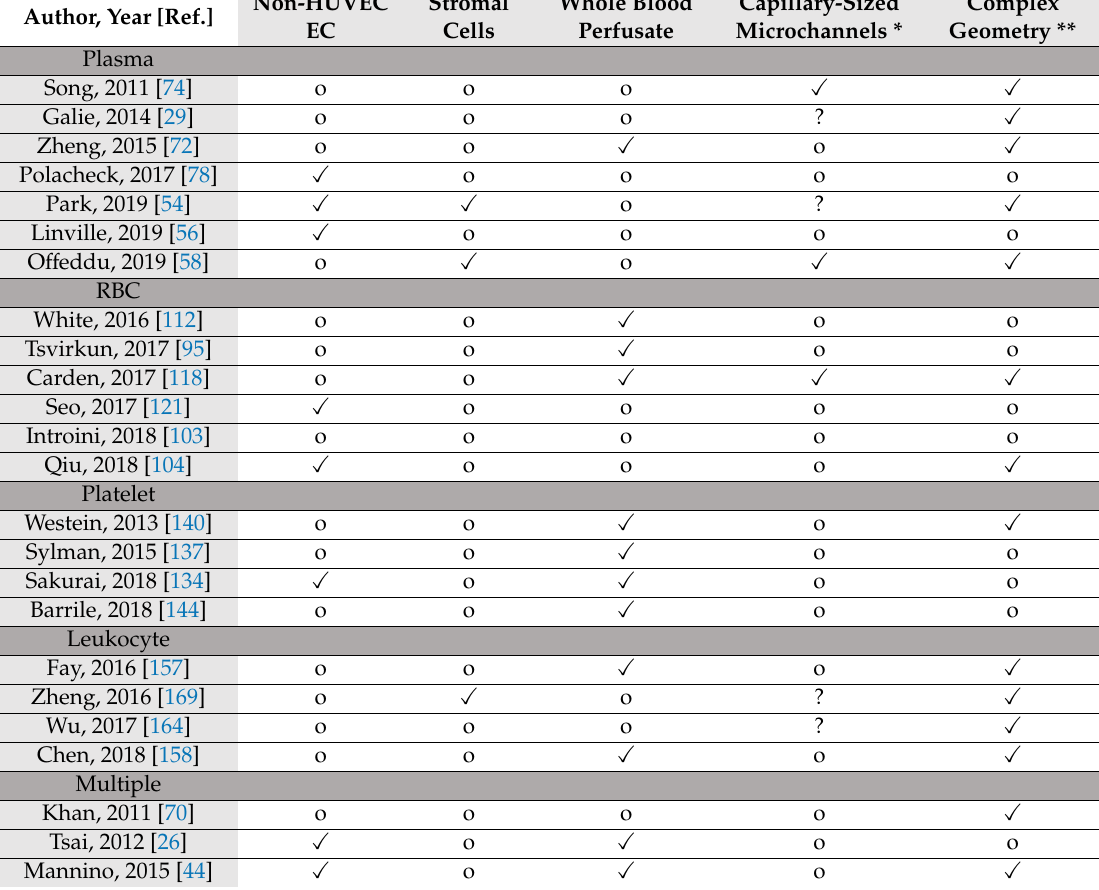
Table 1. Vascularized microfluidic devices outlined in this review and their ability to incorporate